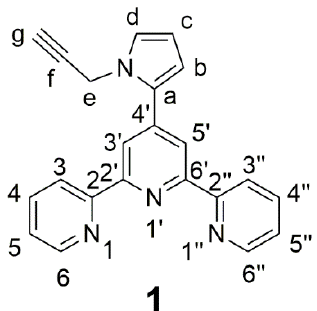
(cid:48) -( N -(propargyl)pyrrol-2-yl)-2,2 (cid:48) :6 (cid:48) ,2 (cid:48)(cid:48) -terpyridine 1 Figure 1. Structure and atom labeling of 4 ′ -( N -(propargyl)pyrrol-2-yl)-2,2 ′ :6 ′ ,2 ″ -terpyridine 1 . Figure 1. Structure and atom labeling of 4